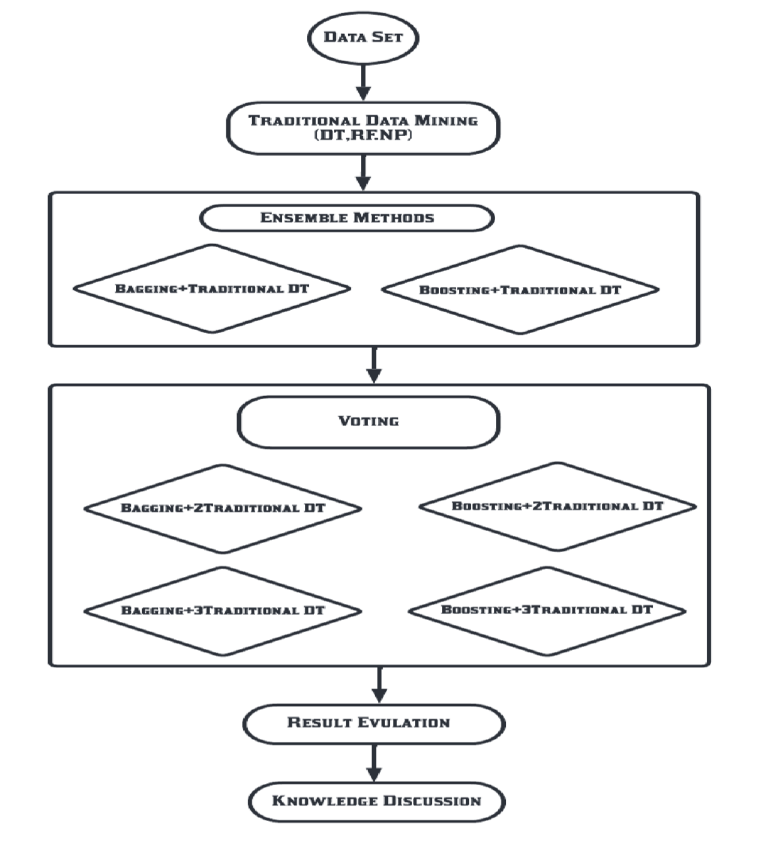
Figure 6. Proposed model for predication of student’s